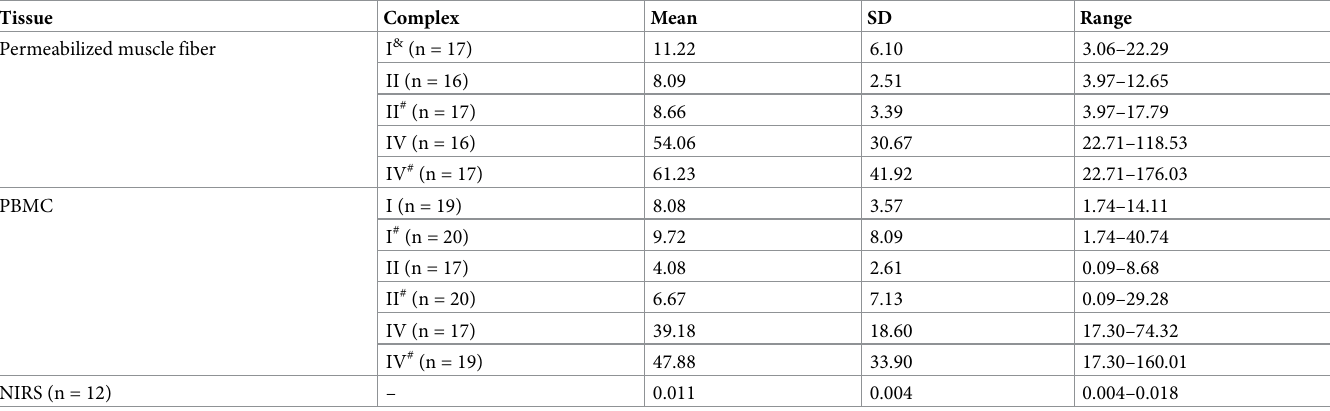
Relationships between PBMCs and permeabilized skeletal muscle fibers While PBMC respirometry analysis was performed on all 20 participants, due to insufficient muscle respirometry analysis was conducted for 19 participants. Subsequent testing error and equipment malfunction similar to failure of the oxygen sensors in the Oxygraph-2k chamber resulted in the loss of all permeabilized skeletal muscle data for an additional 2 participants and the loss of 1 data point for PBMC complex I and IV. Initial analysis also revealed 3 data points among PBMC complex II measures, 2 data points among PBMC complex IV, and 1 data point among permeabilized skeletal muscle complex II and complex IV to be outliers using Q-Q plots. Normality was found among each of the variables. Table 2 provides mean val- ues of mitochondrial respiration measured from PBMCs and permeabilized skeletal muscle Table 2. Bioenergetic profiles of SCI study subjects.